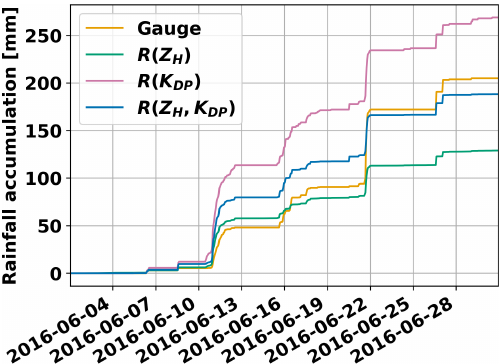
Figure 2. The 1-month 1h rainfall cumulative accumulations for Sürgavere radar data and Jõgeva station gauge data. Z H is not cor- rected for attenuation.